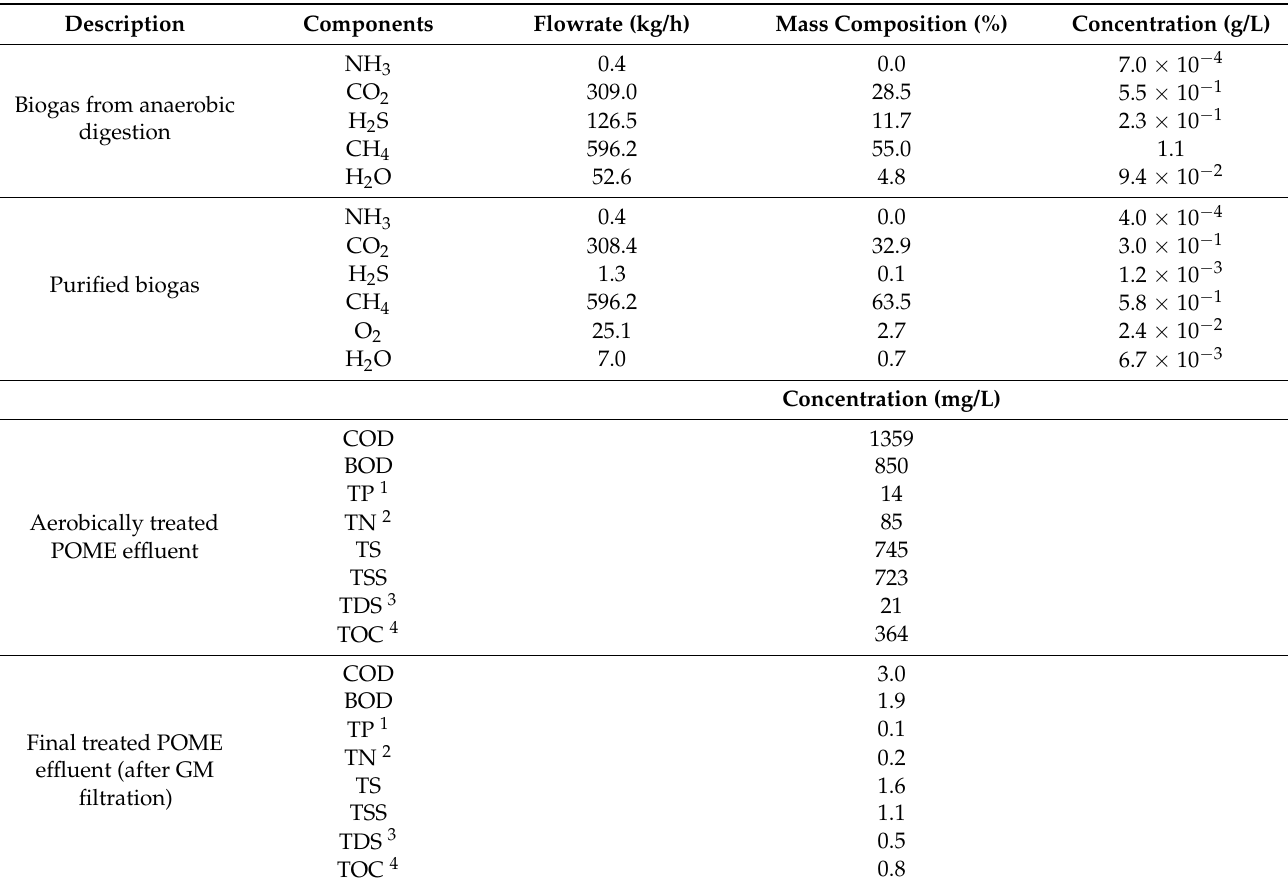
Table 2. Simulated environment properties of POME effluent and biogas